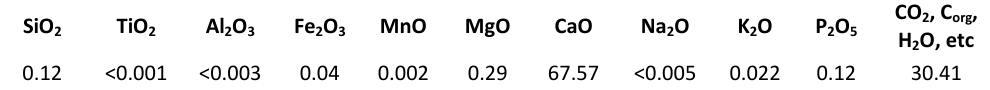
Table 1. Main compounds (%) of newly derived raw medical material defined by x-ray fluorescence method